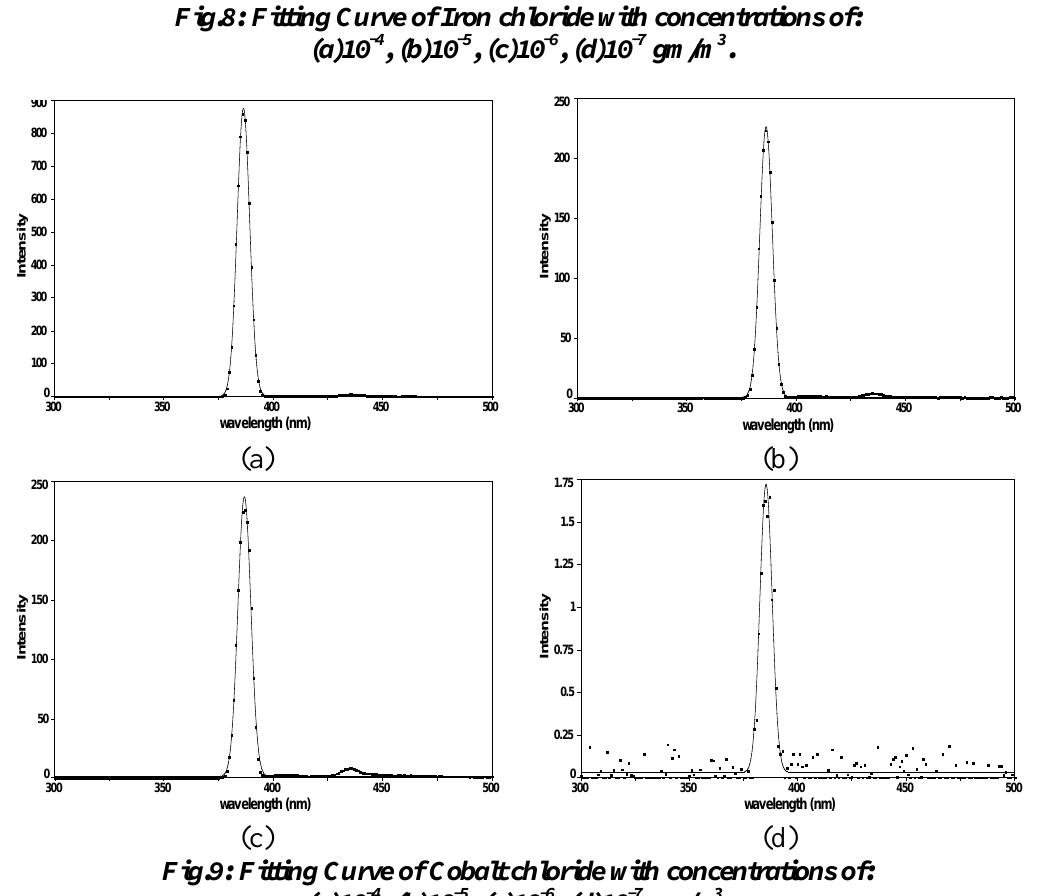
Fig.8: Fitting Curve of Iron chloride with concentrations of: